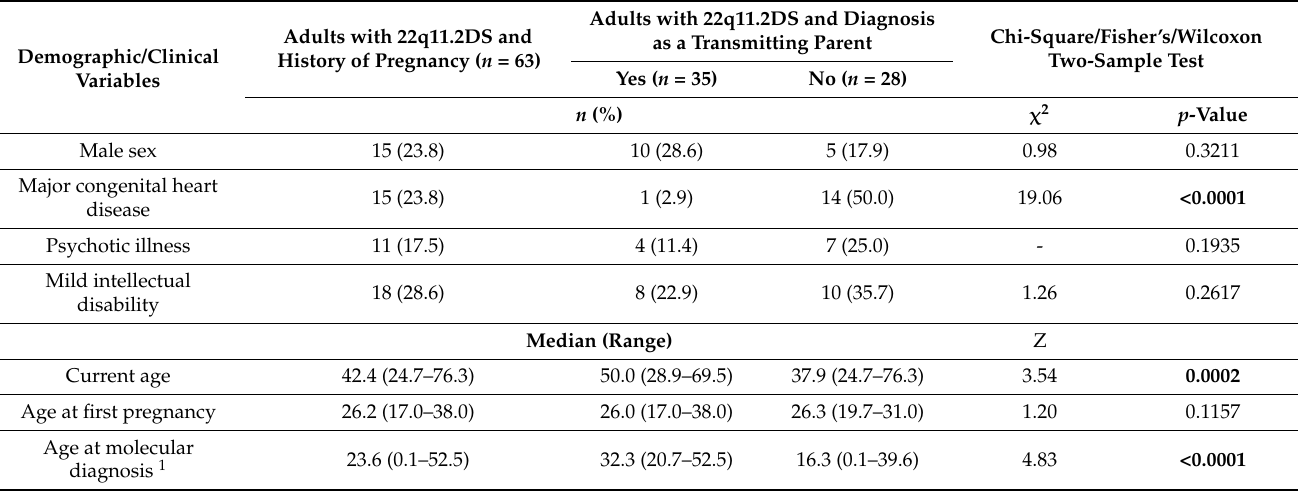
Table 1. Demographic and clinical variables for 63 adults with 22q11.2DS with a history of pregnancy assessing possible effects of diagnosis as a transmitting